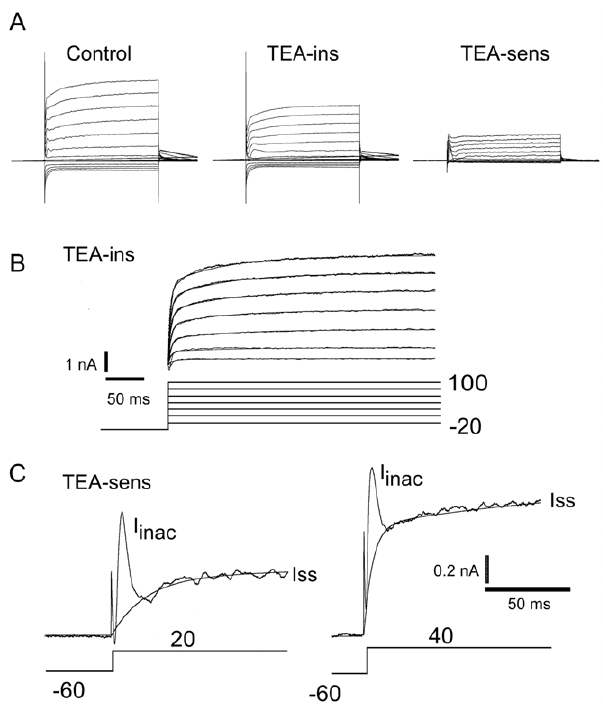
Figure 7. Detailed analysis of the kinetics of the TEA sensitive current. (A) Perforated whole-cell patch on a P15 SN DA neuron. Currents are in points, fits are continuous lines. Protocol identical to the one used in figure 6. Control trace (marked CONTROL) is shown before the application of 20 mM TEA. (B) The application of TEA reduces the current to the TEA insensitive current ( I TEA - I ). The trace shown is obtained from panel A middle after a capacitance subtraction. This TEA- insensitive current has the characteristic * 4 ms activation seen in figures 5 at P0. This current was fit according to the equation A i (1 { exp( { t = t i ) . This fit is superimposed on the whole- I ( t , V ) ~ P i cell current as a continuous line. Two time constants were necessary to fit the data, a voltage independent fast component of * 4–7 ms, and a slow one of * 85 ms (V test from 2 20 to 100 mV, step 20 mV, the slow component was fit by t s =85, 85, 85, 86, 88, 84, and 85 ms respectively). (C) Two components can be detected in the I TEA - S current of the SN DA neuron. A step depolarization to + 20 mV (C left), or + 40 mV (C right) produces two types of currents that are sensitive to TEA. The I inac component is characterized by a voltage dependent activation and a voltage independent inactivation time constant ( t * ; 5 ms). The I ss component is characterized by a voltage dependent activation time constant. The lines are the fits to the I ss current shown. In the left trace, t 1 (activation) * 20 ms, and in the right hand side, t 1 (activation) * 5 ms. A second voltage dependent component with slower time constants was used to fit these data ( t 2 ~ 100 ms, lhs panel and t 2 ~ 50 ms, rhs